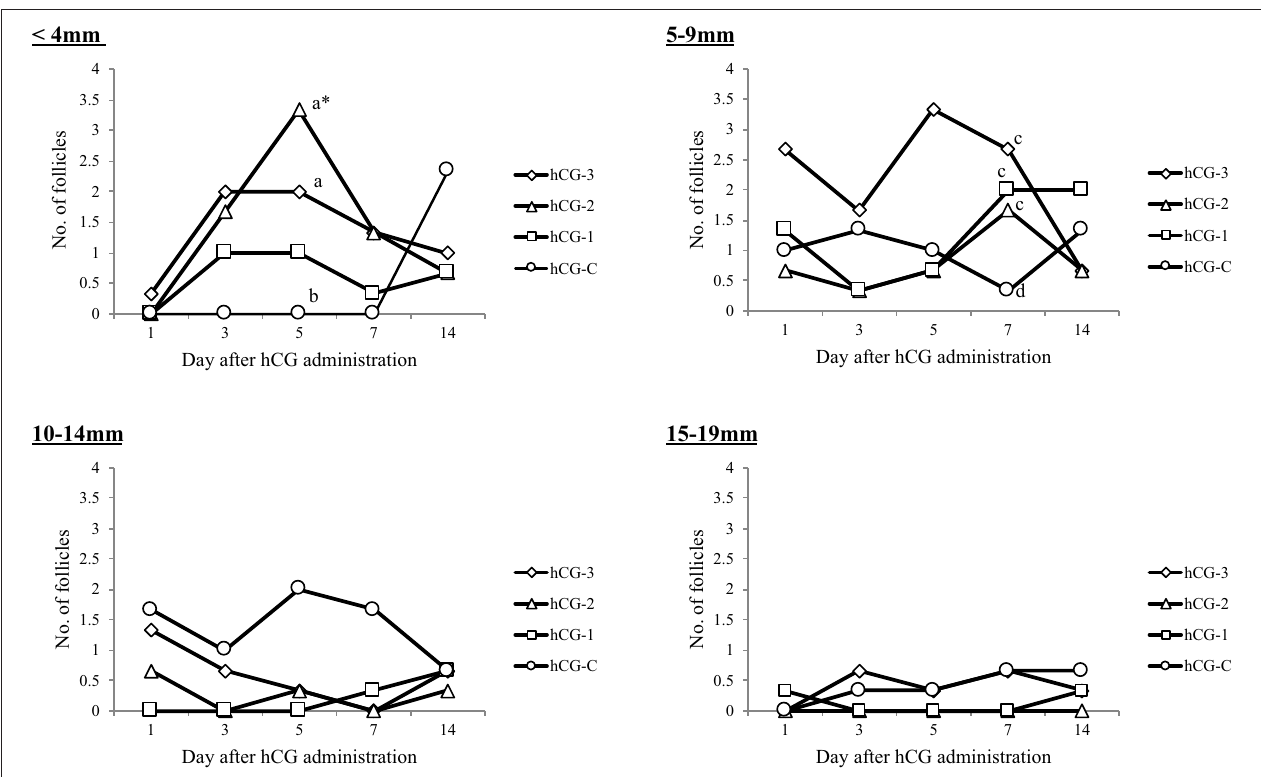
FIGURE 2 | Mean number of developed follicles, categorized by diameter, in each group. *Indicates that the number of follicles on day 5 in the hCG-2 group was significantly different than other days within the group; a,b, significantly different ( P < 0.05); c,d, tendency for a difference ( P < 0.1).